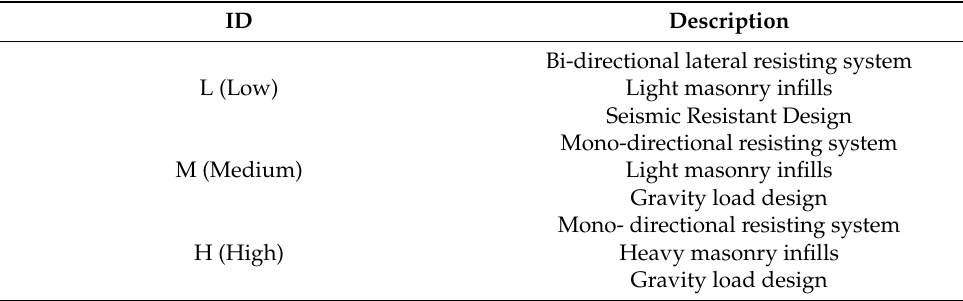
Table 2. Preliminary macro-typologies classification.